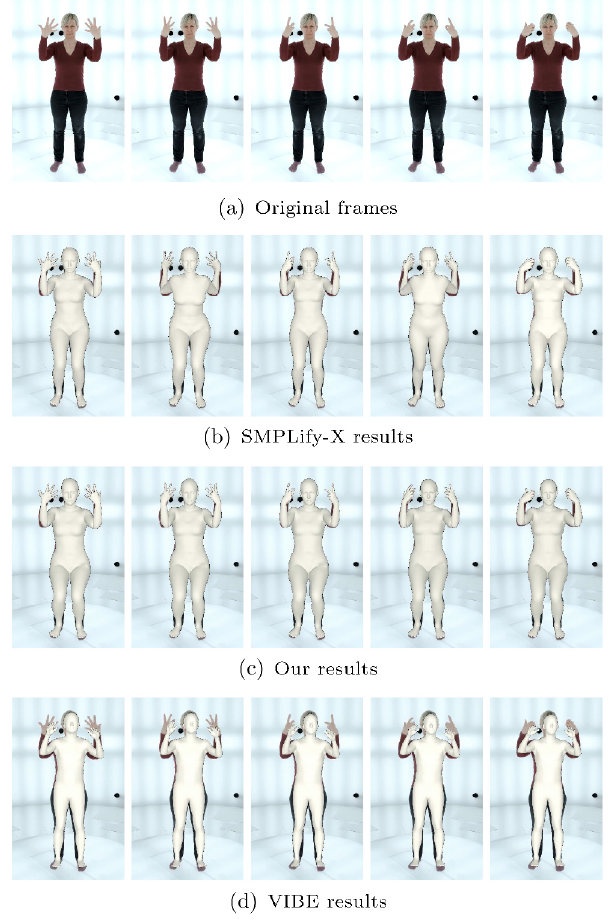
Fig. 5 Shape and pose estimation results for an image sequence of own-data with sign language. SMPLify-X inconsistently captures body shape, with severely disfigured arm poses and wobbling legs, while our work stably estimates shape and motion, close to reality. VIBE is temporally stable but unable to capture complex hand motion.